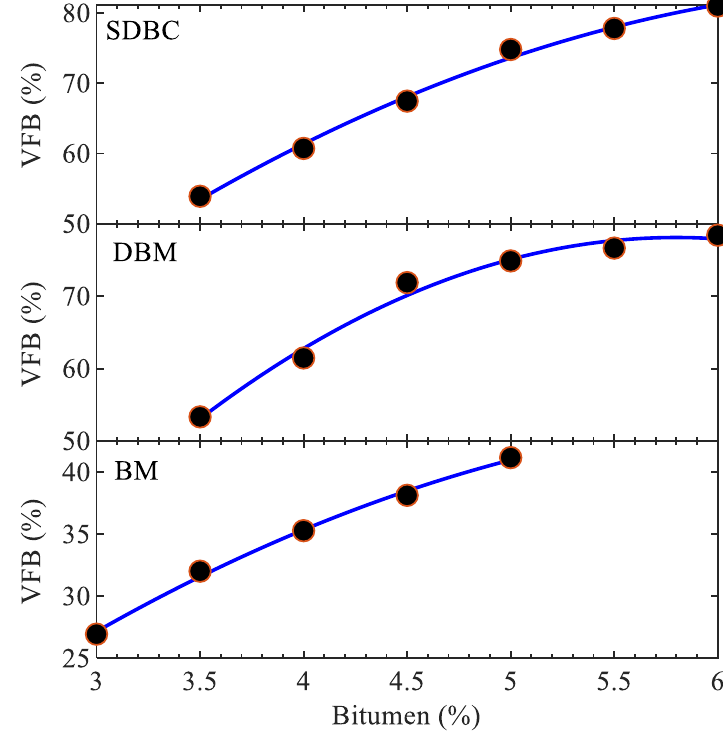
Fig. 10 Relations between voids filled with bitumen with bitumen content for SDBC, DBM, and